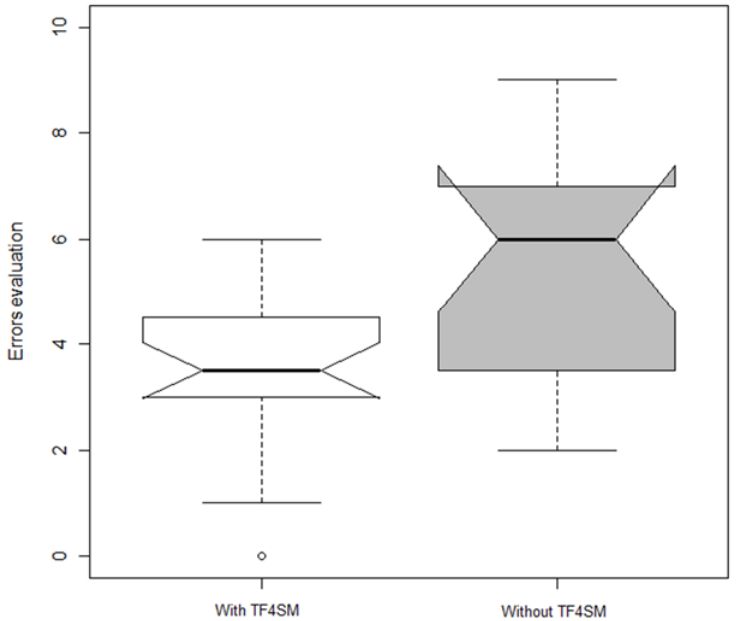
Figure 14. Response time to inefficiencies